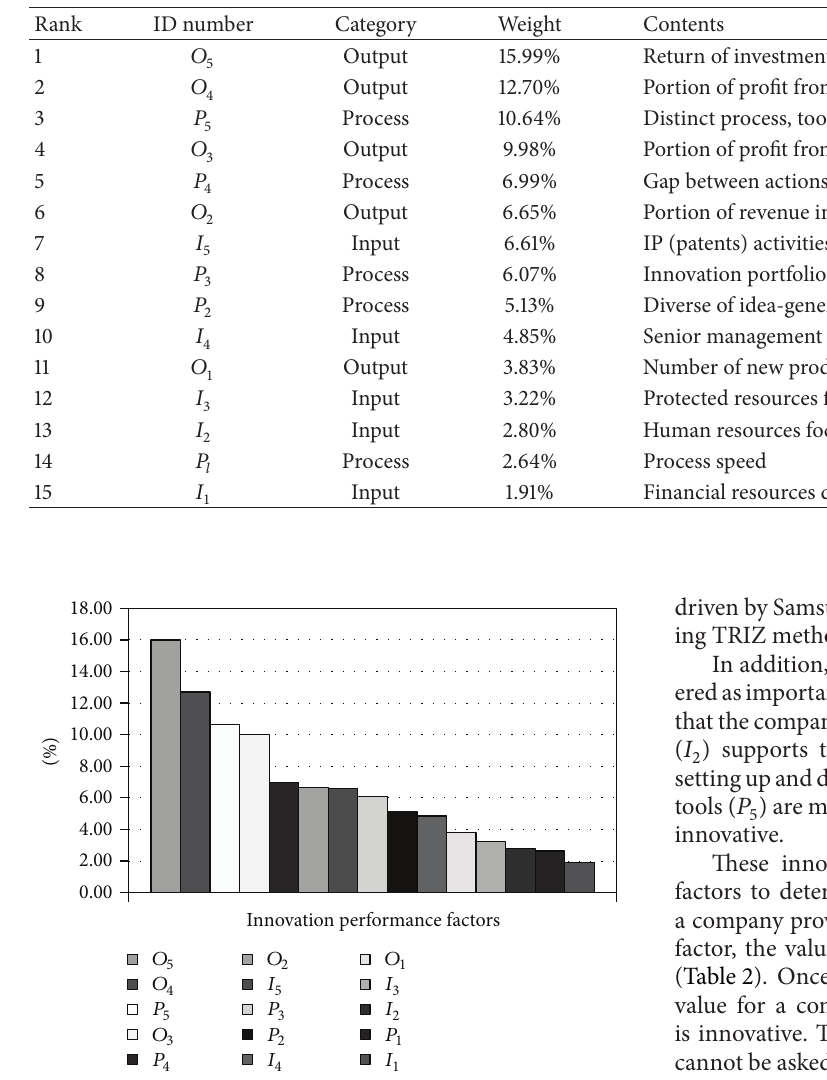
Table 2: Ranking chart of innovation performance factors.